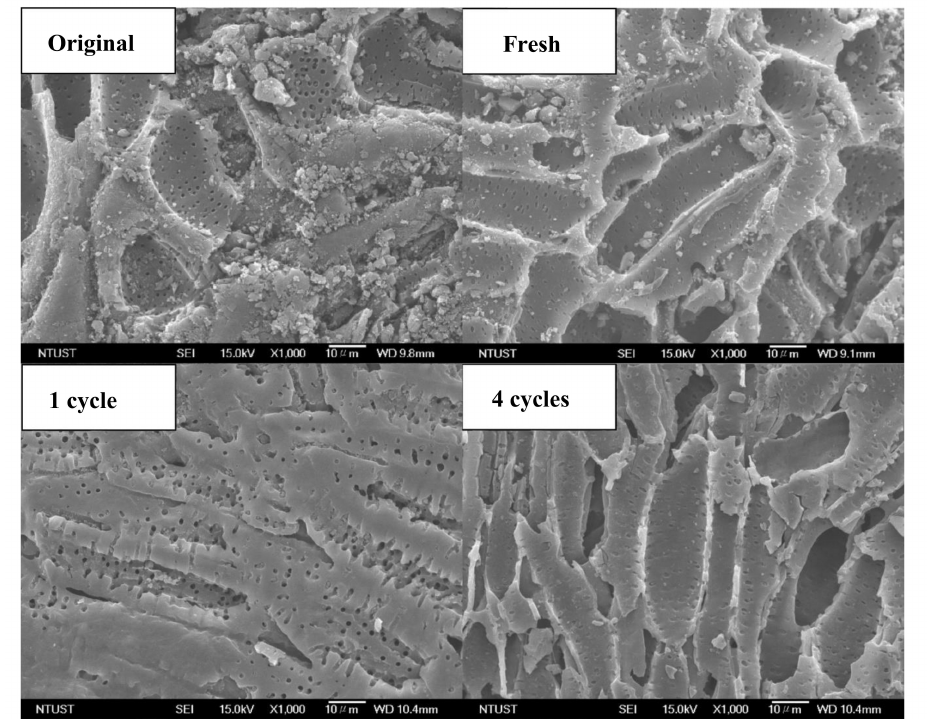
Figure 2. SEM images of original, fresh and regenerated activated carbon at 1000 × magnification.